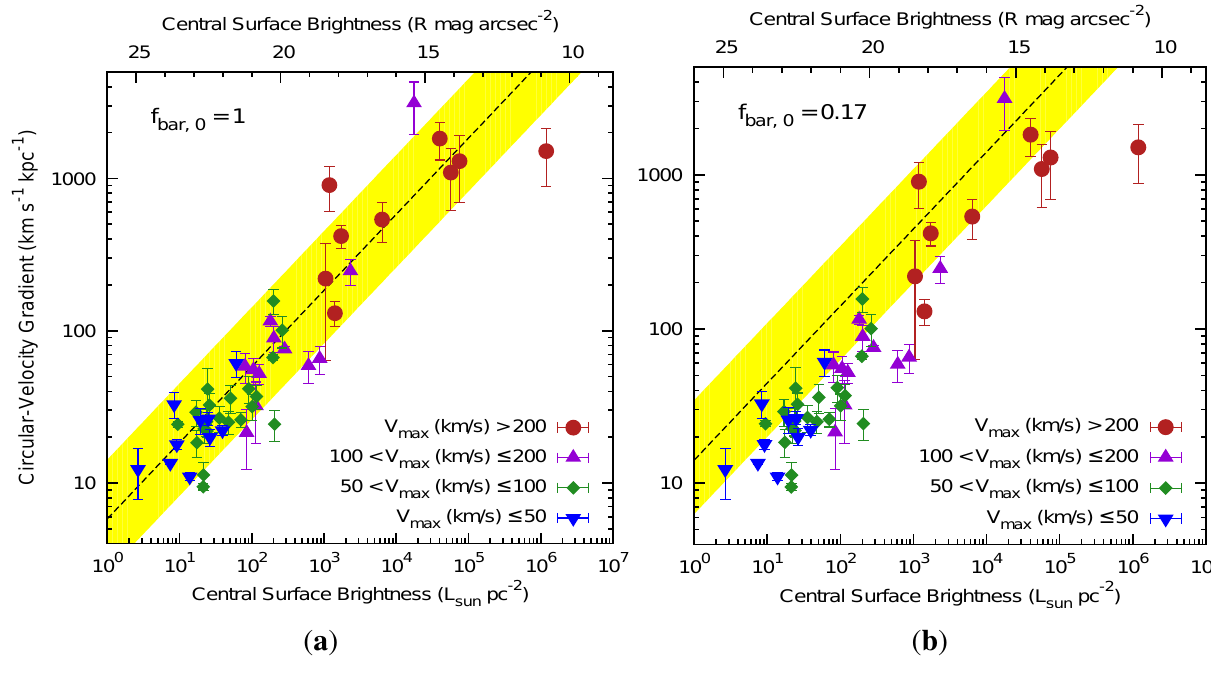
V − Σ Figure 1. The d scaling relation. Galaxies are coded by the value of the maximum R 0 ∗ , 0 (cid:38) 10 3 L velocity V observed along the rotation curve. Galaxies with Σ pc − 2 are max ∗ , 0 (cid:12) typically dominated by a bulge component in the inner parts and have more uncertain values V of d (see [18], for details). The yellow band shows a model where the central baryonic R 0 = 1 ; ( b ): f = 0 . 17 ); the width of the fraction is constant for each galaxy (( a ): f bar , 0 bar , 0 /L band considers that the value of M can vary from 1 to 3, ∆ z from 100 to 500 pc, bar R /L = 2 , and α from 0.5 to 1. The dashed line indicates an “intermediate” model with M bar R ∆ z = 300 pc, and α = 0 . 75